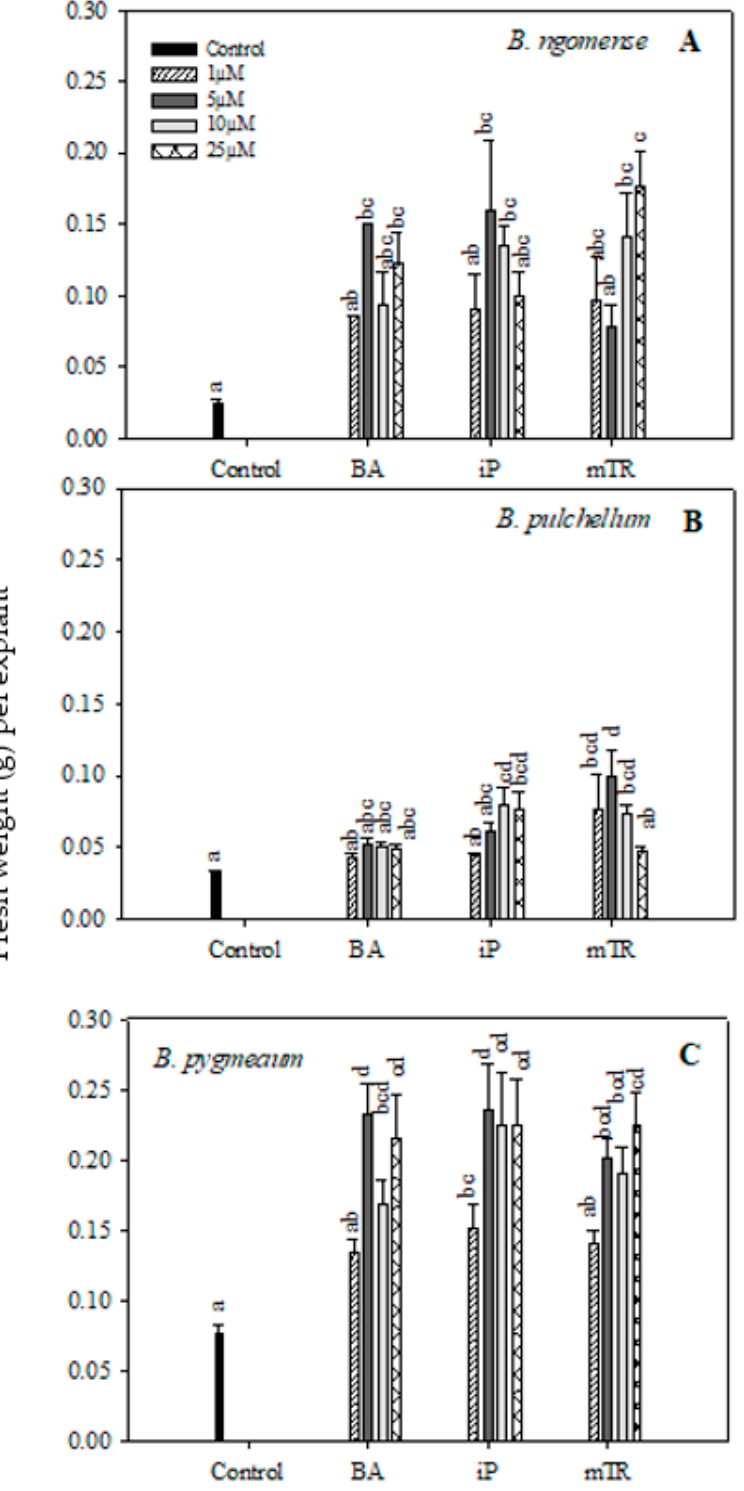
Figure 4. Effect of varying concentrations of cytokinins on fresh weight (g) in ( A ) Brachystelma ngomense , ( B ) Brachystelma pulchellum and ( C ) Brachystelma pygmaeum after six weeks in culture. In each graph, letter(s) on the bars show significant differences according to Duncan’s multiple range test (DMRT) ( p ≤ 0.05). N 6 -benzyladenine (BA), isopentenyladenine (iP) and meta -topolin riboside ( m TR).